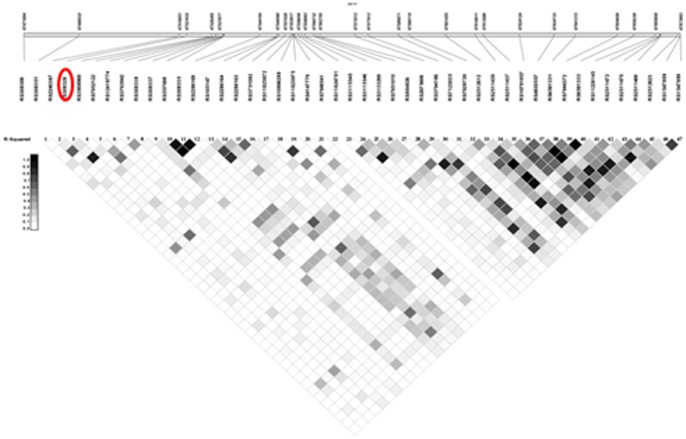
Linkage disequilibrium 100 kb flanking rs308328 in African American T2D cases and controls.We calculated pairwise LD (r2) around our most significant finding (circled in red) from the admixture scan in this African American study population using Haploview [37].